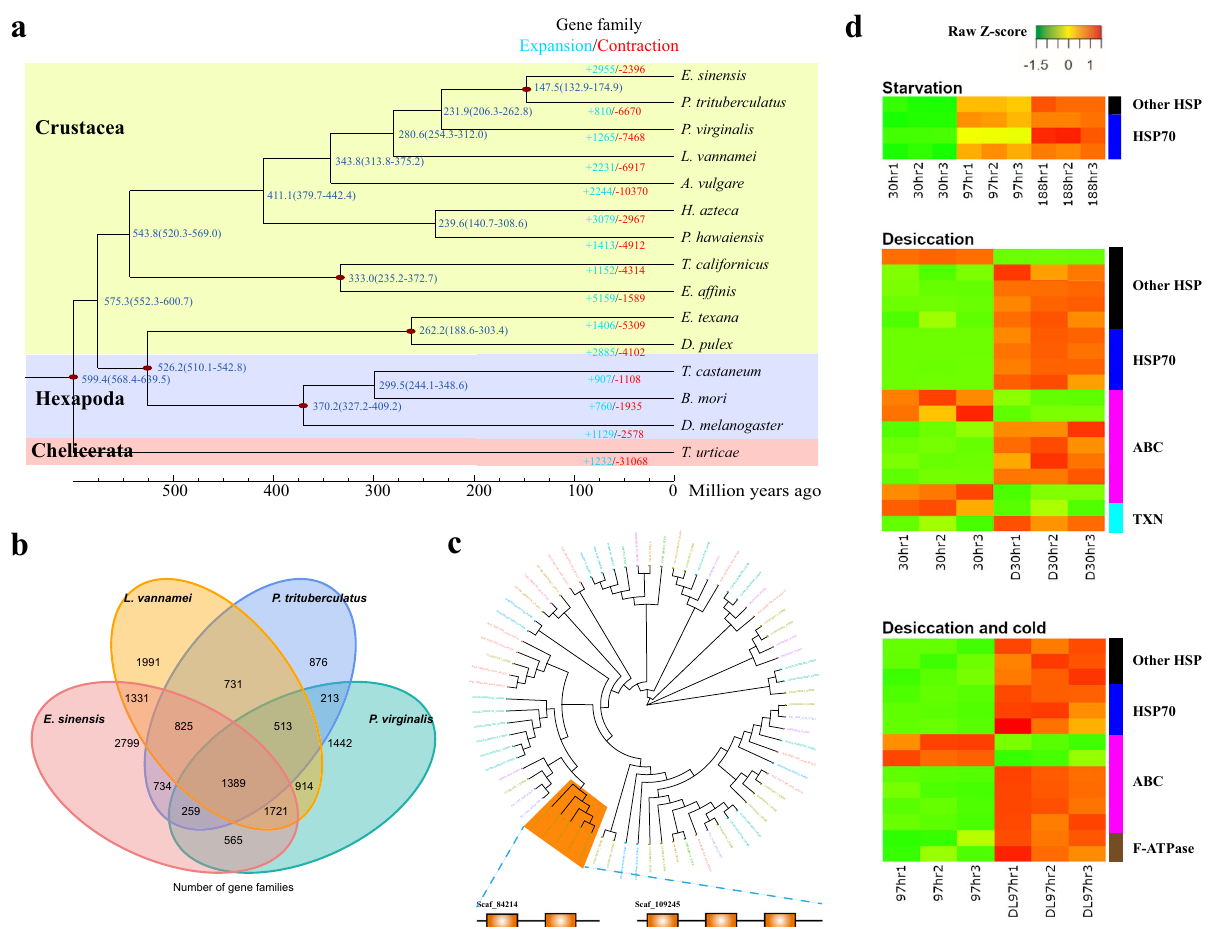
Fig. 2 Comparative and evolutionary analyses of the Eriocheir sinensis genome. a Gene family expansion/contraction analysis of 15 selected species. A total of 2955 gene families are expanded in E. sinensis relative to other arthropods. Expanded and contracted gene families are highlighted in blue and red, respectively. b Venn diagram of shared and unique gene families in four decapod species. c Expansion of HSP70 in the E. sinensis genome, which are also tandemly duplicated. d Expression patterns of HSP, ABC, F-ATPase, and TXN in response to starvation, desiccation and low temperature. 30hr, 97hr and 188hr, starvation for 30, 97, and 188 h at 20 °C; D30hr, desiccation at 20 °C for 30 h; DL97hr, desiccation at low temperature (5 °C) for 97